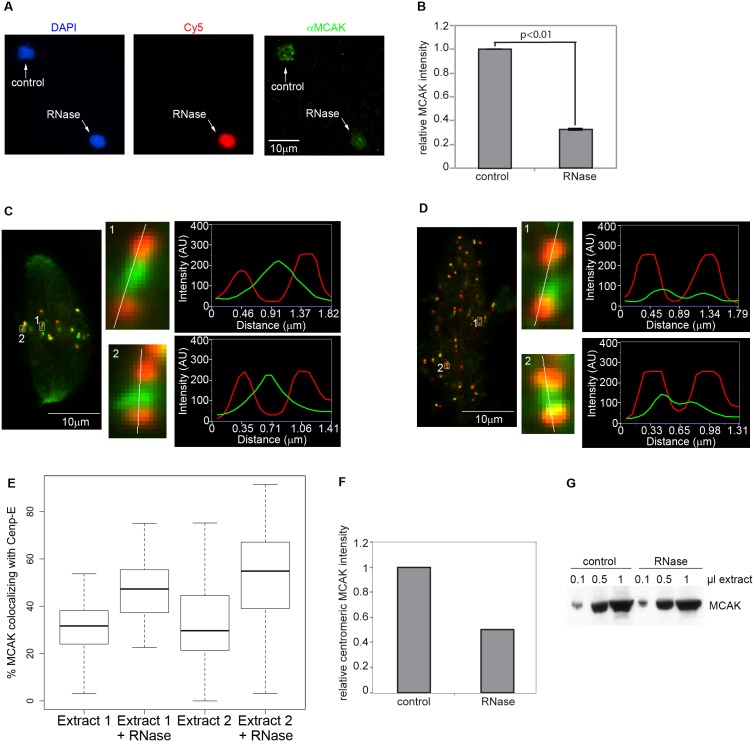
MCAK localization to centromeres is defective in RNase-treated extracts.
A) MCAK localization was assessed on nuclei cycled through interphase and rearrested in metaphase in the presence of nocodazole. Control or RNase-treated nuclei (the latter labeled with Cy5-dUTP) were fixed, copelleted onto a single coverslip, and processed for αMCAK immunofluorescence. Pairs of control and RNase-treated nuclei in the same field of view were assayed for MCAK localization. Images shown are projections, except for Cy5, which is a single plane. B) Quantitation of centromeric MCAK levels from (A). (n = 3 extracts, 14–20 pairs of nuclei per extract, p<0.01 by single-sample t-test of average normalized values from each extract). Error bars represent SEM. C) Localization of Cenp-E (red) and MCAK (green) to sister kinetochores in control spindles. Insets show single pairs of kinetochores magnified 12x, and a line scan of Cenp-E and MCAK intensities along the indicated trajectories. D) Same as in (C), but RNase-treated. MCAK signal has been enhanced in kinetochore insets. C–D) Images shown are single planes. Kinetochore insets are magnified 12X. E) Quantitation of data shown in (C–D). Box plot showing the distribution of MCAK overlap with Cenp-E in two independent extracts. Box represents the median and upper and lower quartiles. Bars show the extent of outliers in each condition. 21–31 kinetochore pairs were measured in each extract. F) Quantitation of centromeric MCAK levels from (C–D). (n = 2 extracts, 5–6 spindles of each category per extract). G) Western blot showing MCAK amounts in control or RNase-treated extracts.